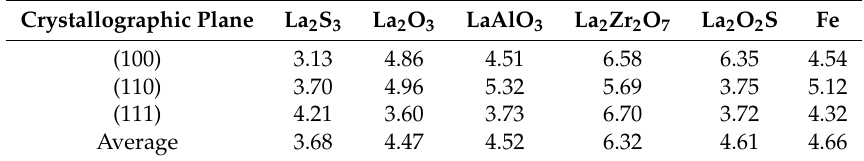
Table 6. Work functions of inclusions and the Fe matrix at three di ff erent low-indexed crystallographic planes